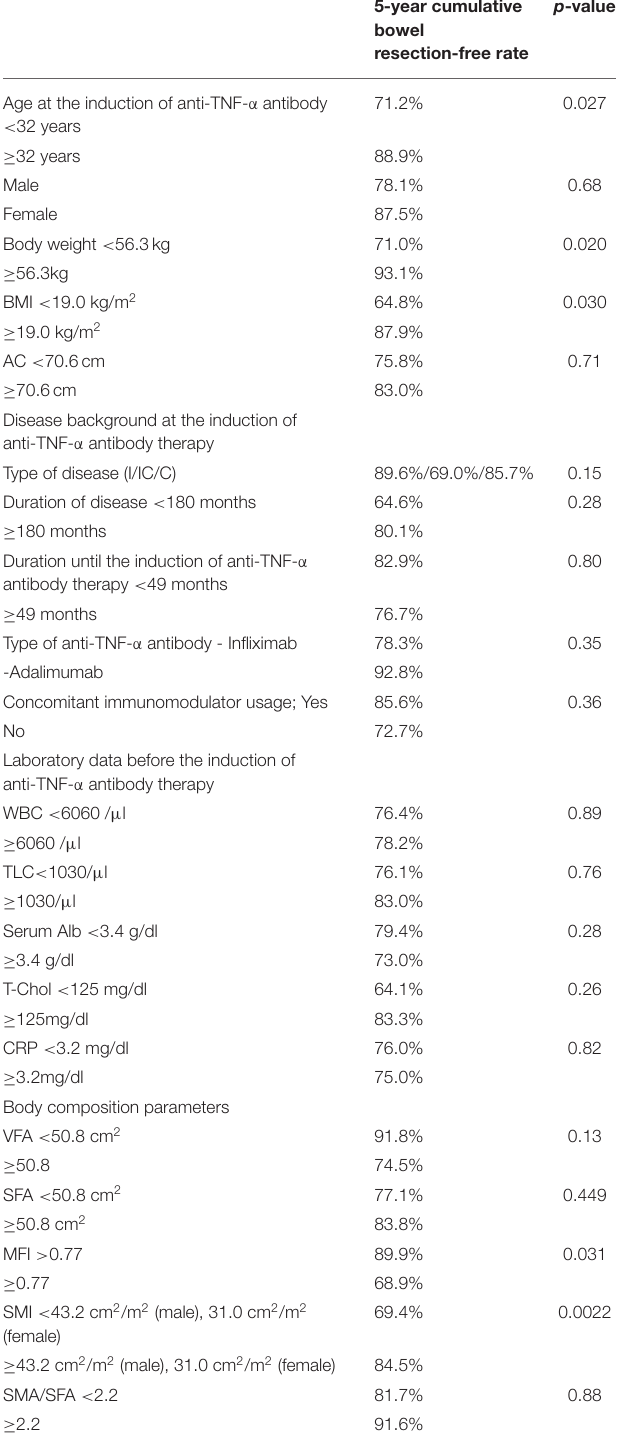
TABLE 3B | Multivariate analysis of factors associated with bowel resection during anti-TNF therapy (Cox proportional hazards analysis). Multivariate